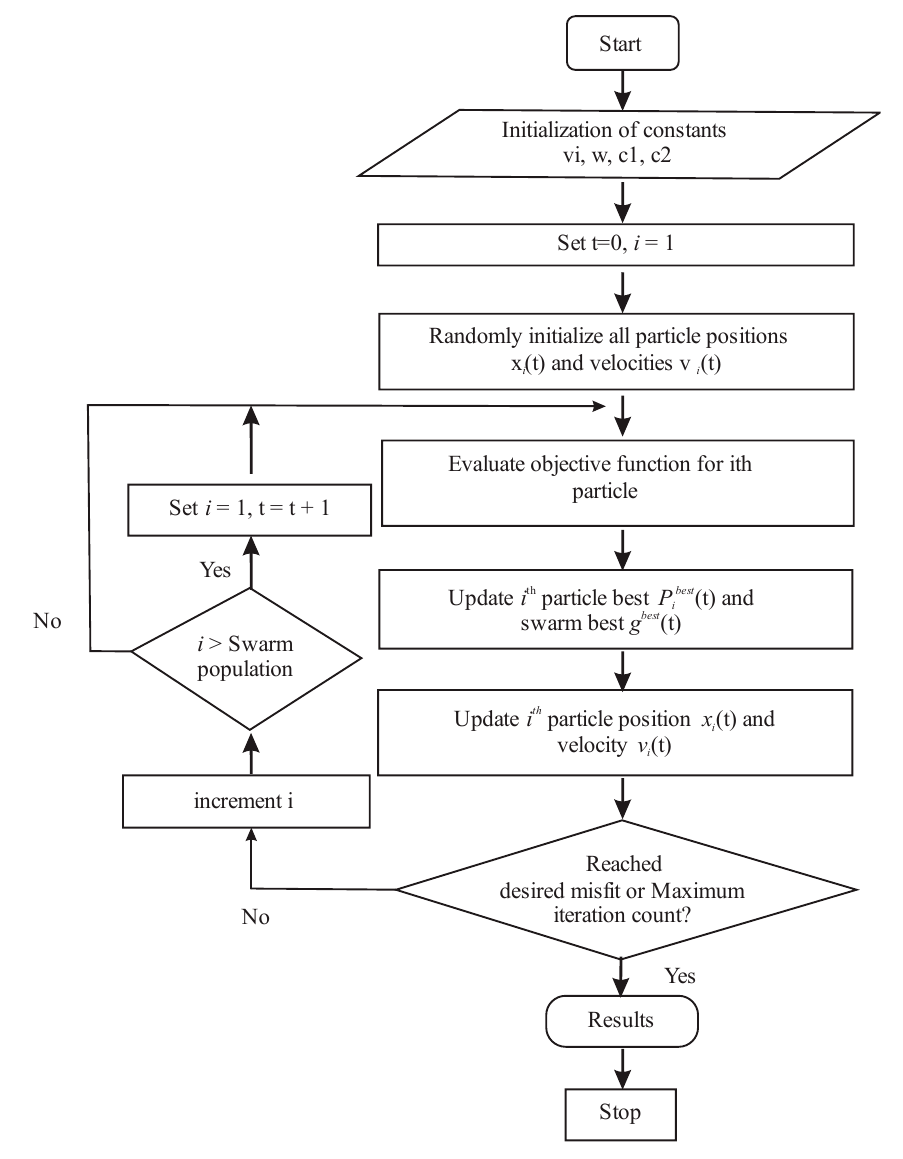
Figure 8. The flowchart for the PSO algorithm [30].